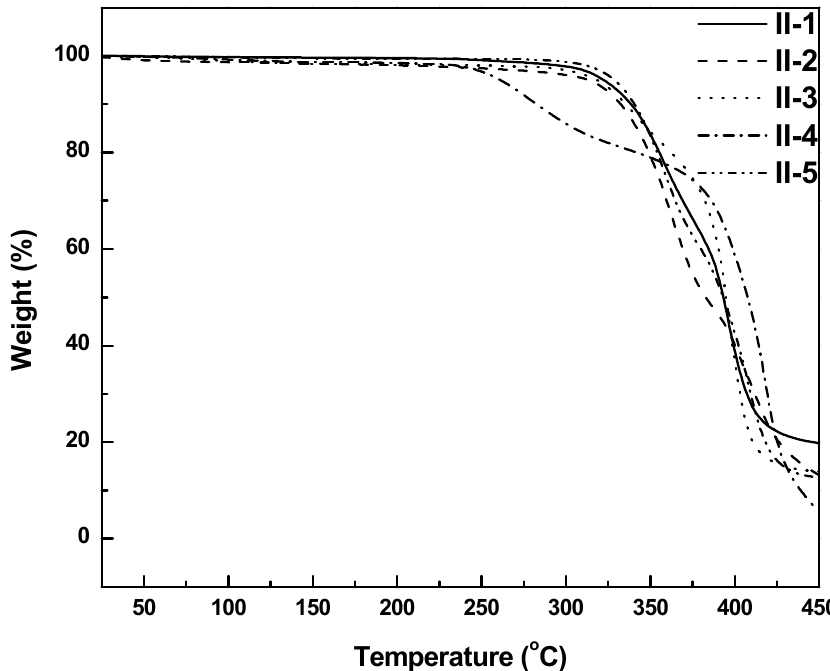
Figure 3. TGA thermograms of polymers II-1 − II-5 obtained at a heating rate of 10 ° C/min in nitrogen.